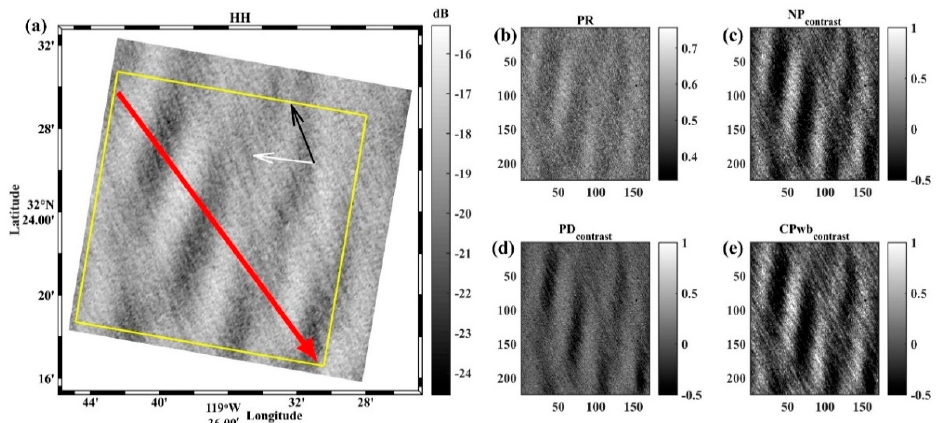
Figure 1. Synthetic aperture radar (SAR) images containing atmospheric gravity waves: ( a ) RS-2 SAR HH-polarized images (dB units) of an area of the West Coast of USA acquired at 13:53 UTC on May 24, 2012. The key parameters associated with the enlarged region of the yellow fragment in ( a ) are estimated as: ( b ) polarization ratio (PR) (linear units); ( c ) non-polarized (NP) contrast; ( d ) polarization difference (PD) contrast, and ( e ) cross-polarized wave breaking (CPwb) contrast. The incidence angle, averaged wind speed and the angle between radar look direction and wind direction are about 44 degrees, 11 m/s and 59 degrees, respectively. The black and white arrows in ( a ) correspond to wind direction and radar look direction. Wind direction is from the NDBC buoy, wind speed from the C_SARMOD2 GMF. RS-2 data are a product of MacDonald, Dettwiler, and Associates, Ltd. All rights reserved.